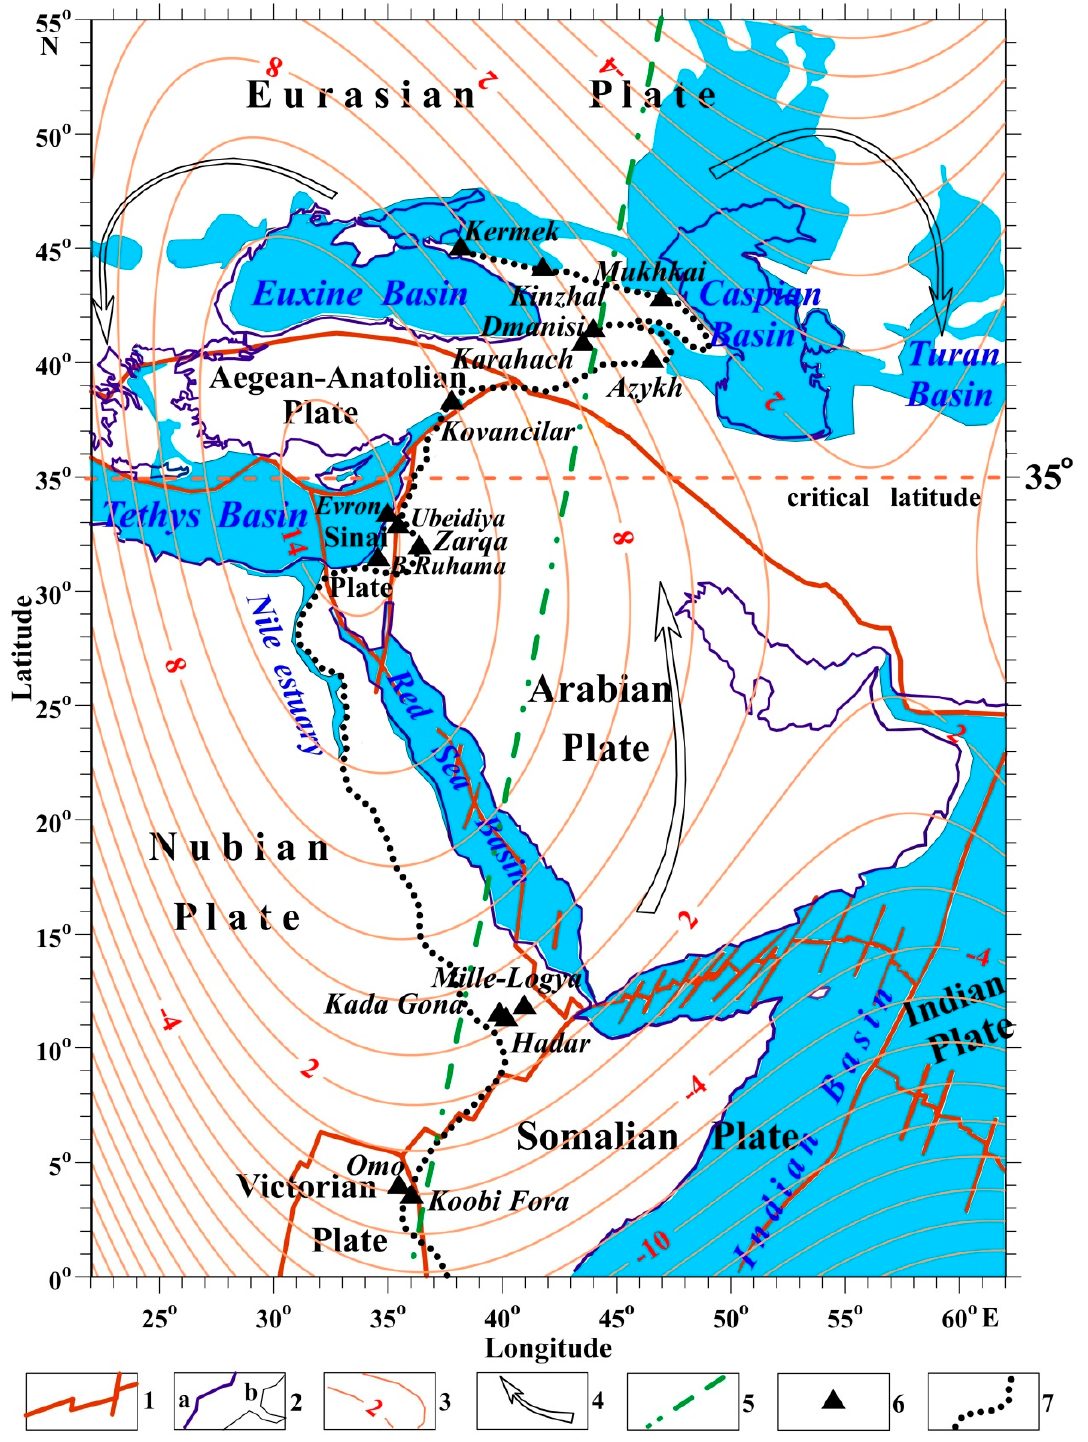
Figure 2. Satellite-derived gravity map with the paleogeographical, tectonic-geodynamic elements and anthropological features. (1) interplate faults, (2) a: modern land-sea boundaries, b: land-sea boundaries during the maximum Akchagylian-Gelasian transgression, (3) residual satellite-derived gravity map, (4) rotation of the Earth ′ s crust according to the GPS observations, paleomagnetic and structural data, (5) averaged position of the Ural-African Step, (6) ancient hominin sites corresponding to the age Akchagylian-Gelasian transgression, (7) reconstructed early hominin way from Africa to Eurasia ((3) and (4) according to [60], and [26,29]). The East African area of origin of ancient hominin (East African Rift Belt) (Figure 1) is located in the zone of the southern pericline of the deep mantle structure [29], where the Nubian, Arabian, Somalian, and Victorian lithospheric plates are joined in the rift